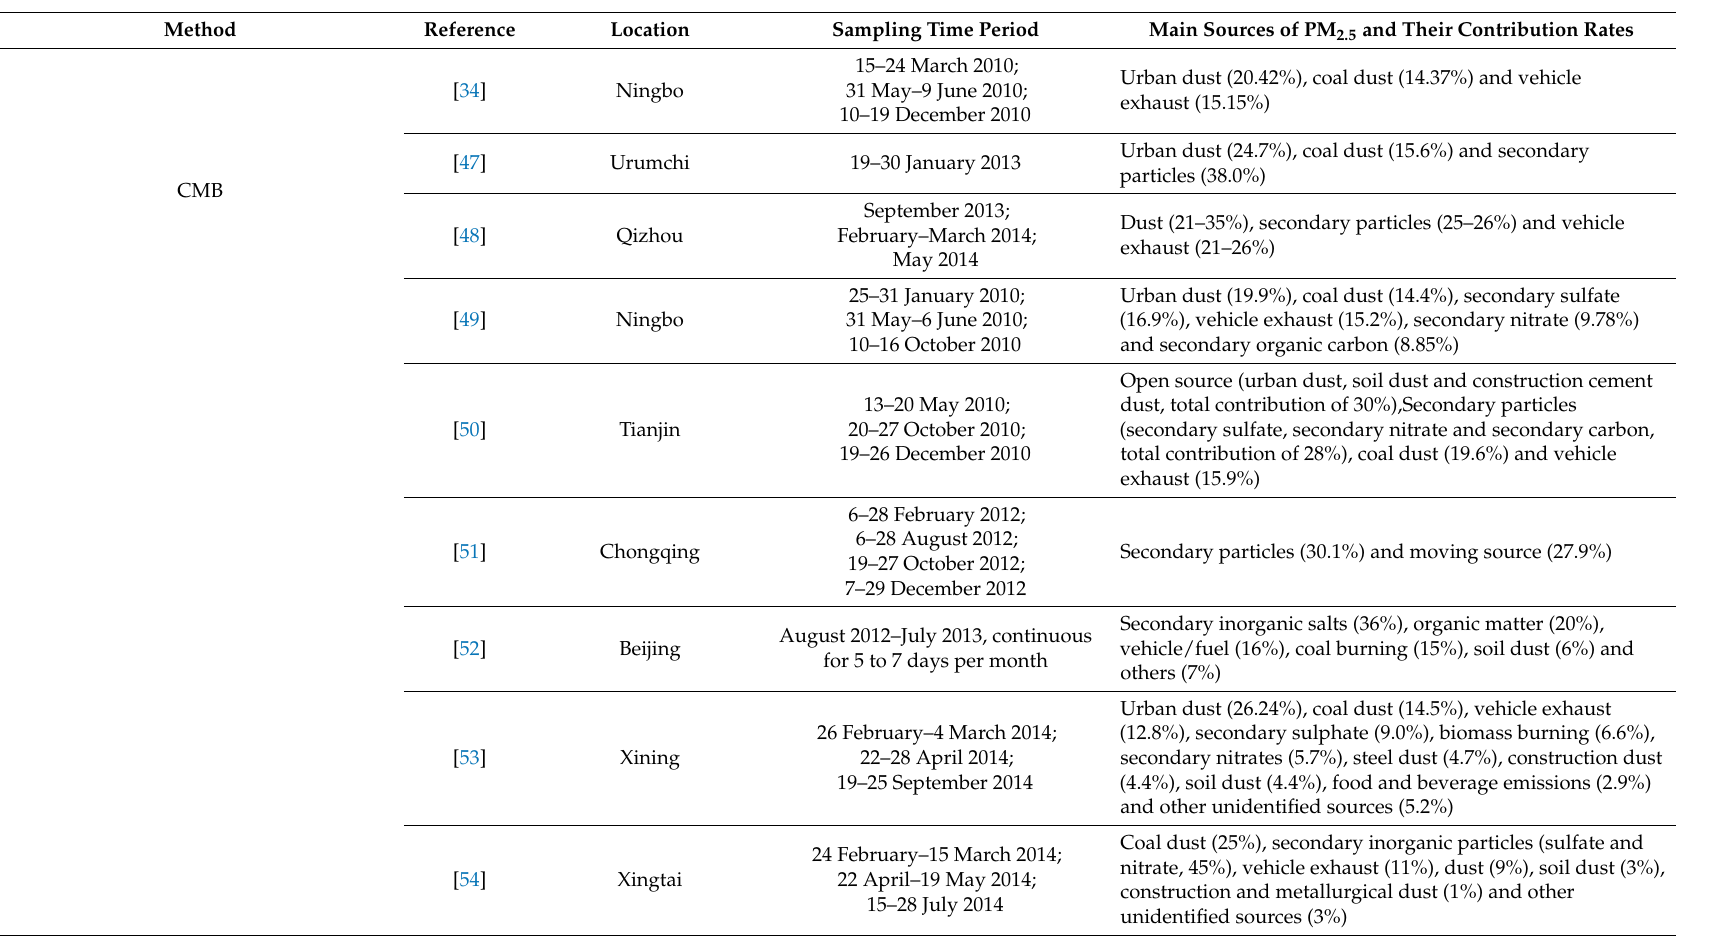
Table 2. Modeling methods and analysis on sources of PM 2.5